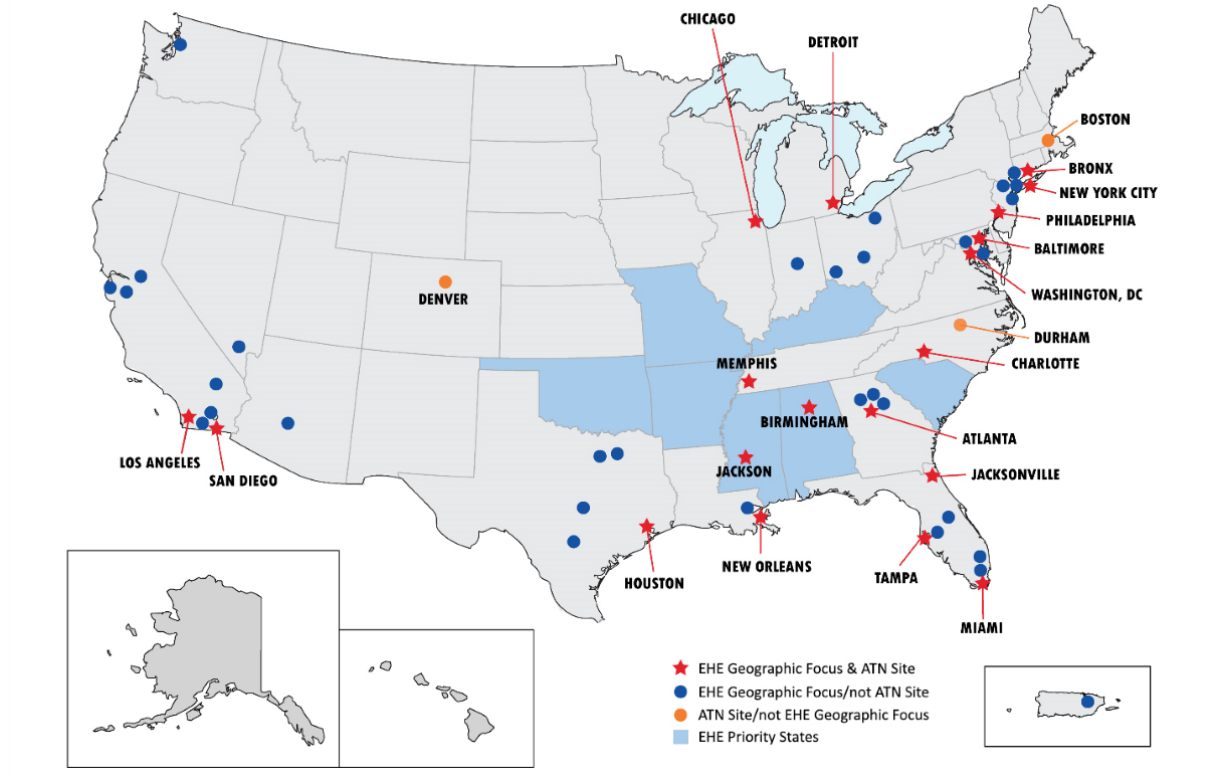
Figure 1. Map of Adolescent Medicine Trials Network for HIV/AIDS Interventions study sites and Ending the HIV Epidemic geographic